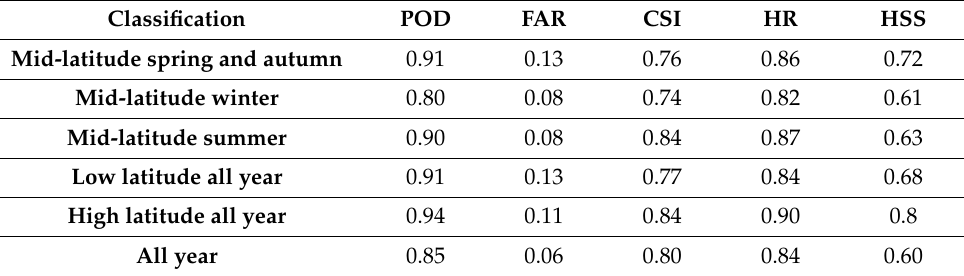
Table 4. Statistics of performance metrics of CP classification for different seasons and latitudes.